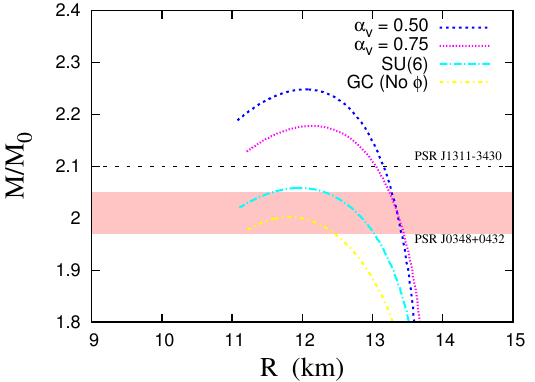
Figure 12. Mass–radius curve for the GM1 parametrisation based on